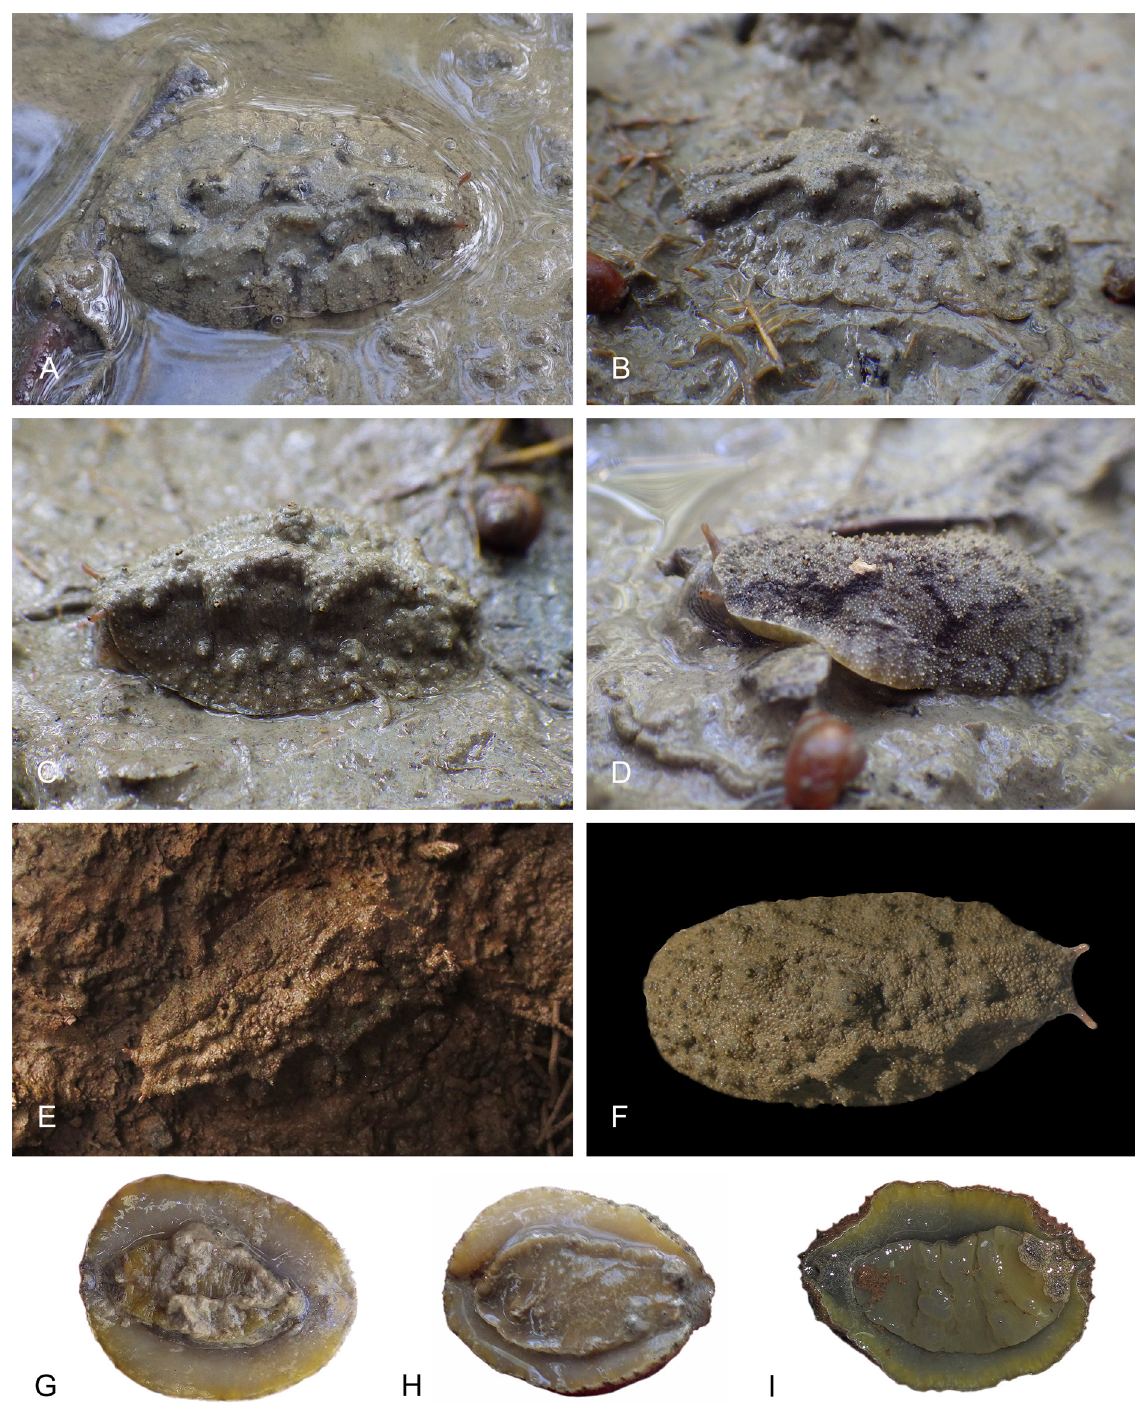
Fig. 41. Paromoionchis penangensis gen. et sp. nov., live animals. A . Dorsal view, 29 mm long [5990], Malaysia, Matang (USMMC 00060). B . Dorsal view, 26 mm long [6039], Malaysia, Penang (USMMC 00063). C . Holotype, dorsal view, 25 mm long [6037], Malaysia, Penang (USMMC 00059). D . Dorsal view, 22 mm long [6031], Malaysia, Penang (USMMC 00063). E . Dorsal view, 37 mm long [1167], India, Maharashtra (BNHS 46). F . Dorsal view, 30 mm long [1129], India, Andaman Islands (BNHS 4). G . Ventral view, same as D. H . Ventral view, same as A. I . Ventral view, 27 mm long [1182], India, Maharashtra (BNHS